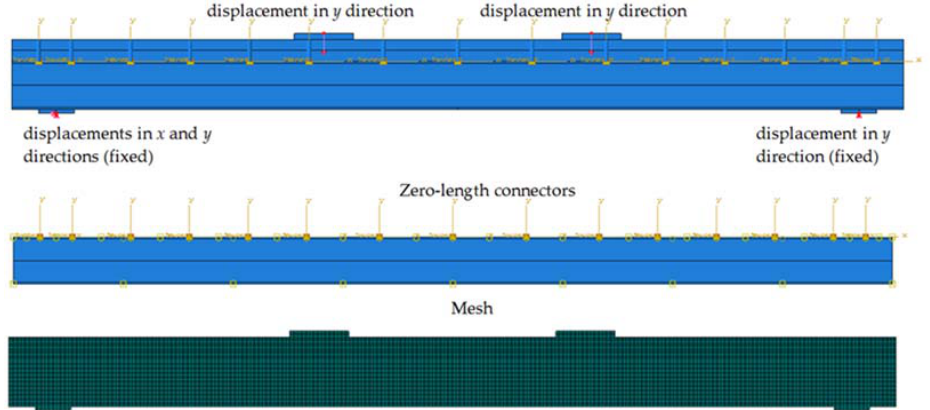
Figure 5. Boundary conditions (B200).